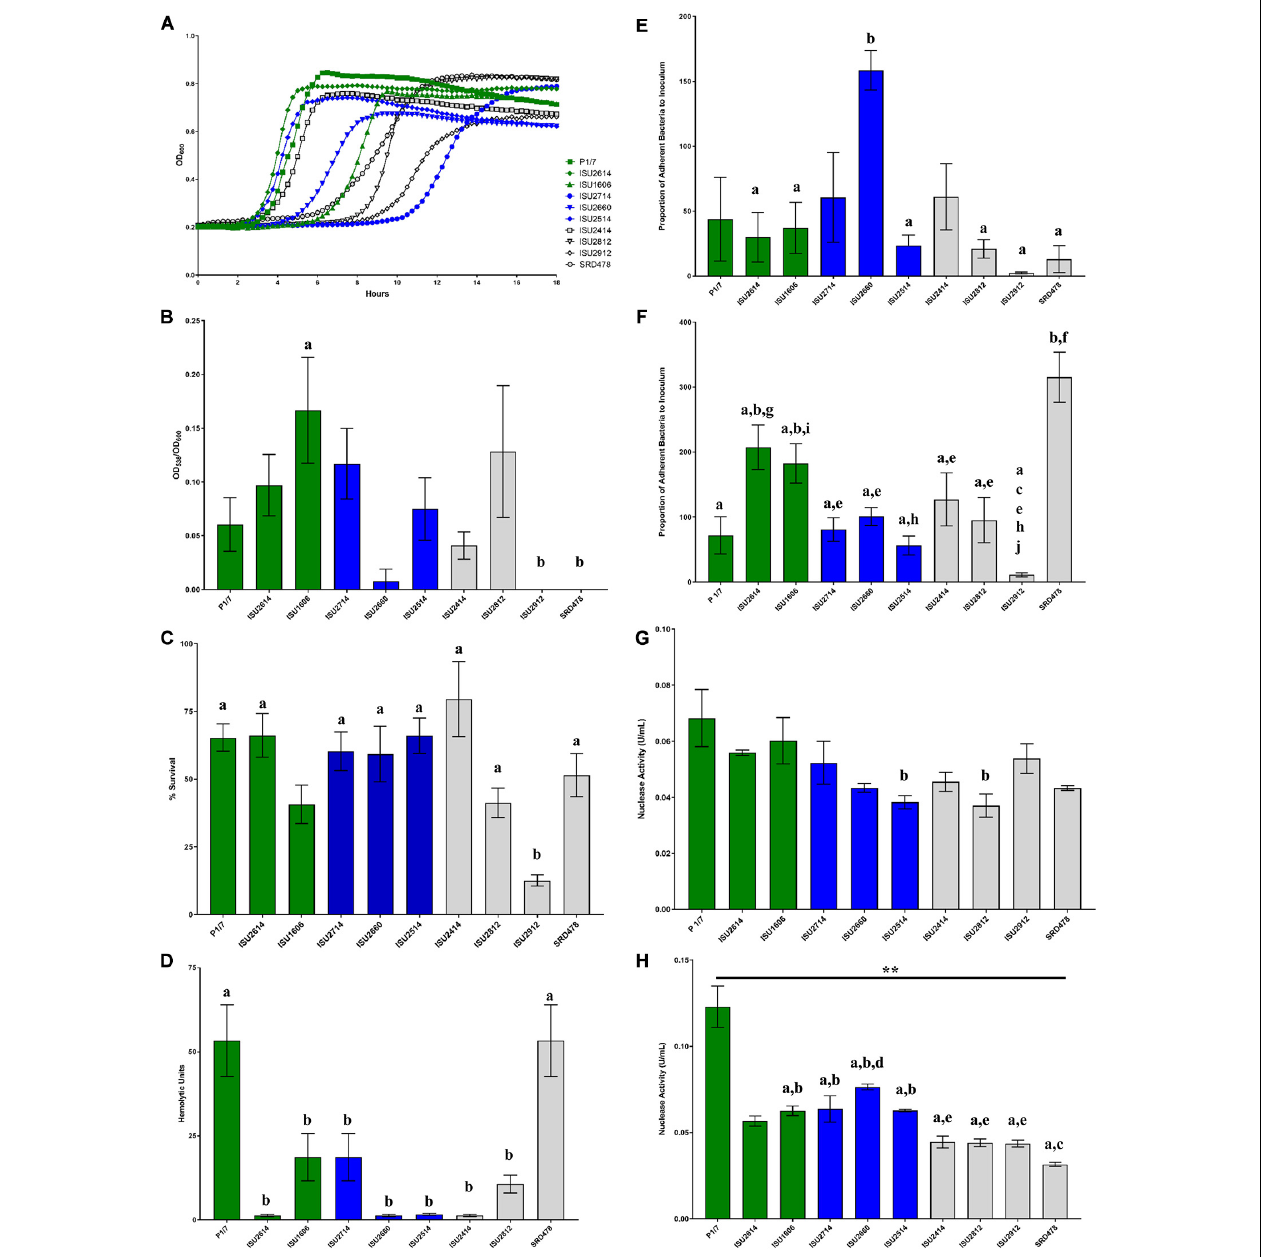
FIGURE 5 | Comparison of in vitro growth and virulence-associated phenotypes. (A) Growth dynamics of S. suis isolates. Isolates were cultivated at 37 ◦ C for 24 h. Growth was measured by OD 600 every 15 min. All data points represent averages obtained from three independent experiments. (B) Biofilm formation by S. suis isolates. S. suis isolates were cultivated statically for 24 h in microtiter plates. Growth was then measured by OD 600 followed by quantification crystal violet staining by OD 538 . Biofilm mass ( y -axis) is expressed as the OD 538 normalized to OD 600 . (C) Oxidative stress assay. S. suis isolates were cultivated until exponential phase and divided into treated (10 mM H 2 O 2 ) and untreated cultures (H 2 0), incubated at 37 ◦ C for 15 min followed by addition of 10 µ g/mL catalase. Bacteria were enumerated to determine the percent survival ( y -axis) calculated as the proportion of treated samples to untreated samples. (D) Hemolysis assay. Hemolytic activity of supernatants collected from S. suis isolates. (E) Adherence of S. suis isolates to BEAS-2B cells. Adherence ( y -axis) to BEAS-2B cells (human lung/bronchus epithelial cell line) is expressed as the proportion of bacteria in the original inoculum found to be adherent after a 2-h incubation period. (F) Adherence of S. suis isolates to macrophages. Adherence ( y -axis) to J774A.1 cells (murine macrophage-like cell line cell line) is expressed as the proportion of bacteria in the original inoculum found to be adherent after a 2-h incubation period. (G) Cell-Associated Nuclease Activity. Cell-associated nuclease activity for S. suis isolates was measured using whole-cell FRET assay. (H) Secreted Nuclease Activity. Secreted nuclease activity for S. suis isolates was measured using extracellular FRET assay. Bars (B–H) represent means ± SEM from three independent experiments. Bar color reflective of virulence categorization (green: highly virulent; blue: moderately virulent; light gray: non-virulent). Data (B–H) was analyzed using a one-way ANOVA with a Tukey’s post-test (GraphPad Prism 8.3.0). Groups with connecting lines were significantly different ( p < 0.0003). Groups with different letter designations were significantly different ( p <